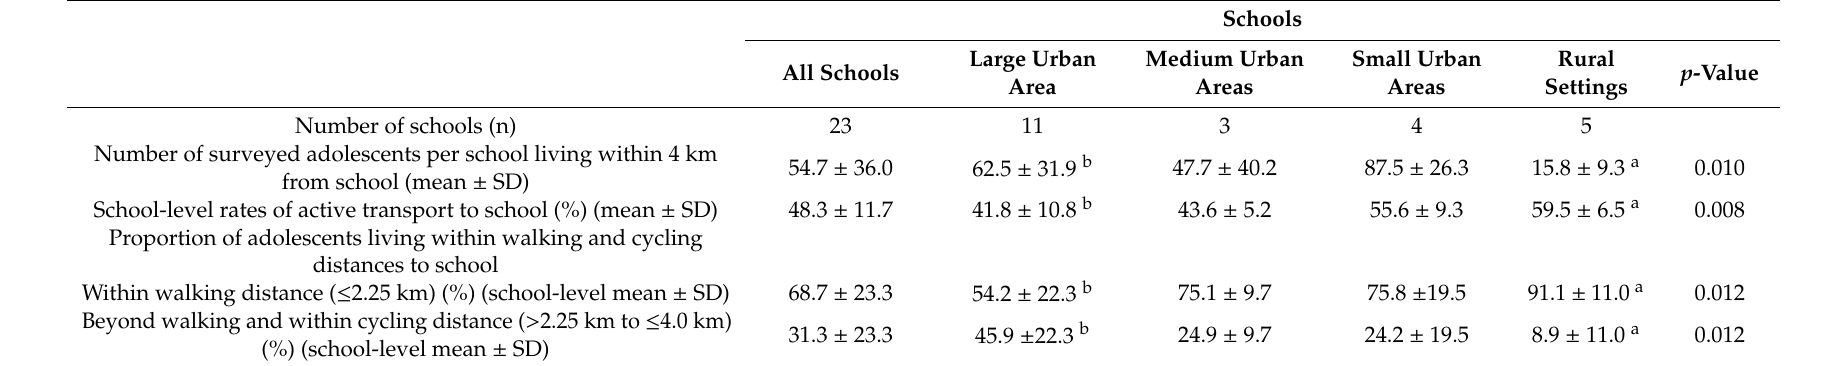
Table 1. School characteristics in di ff erent urbanisation